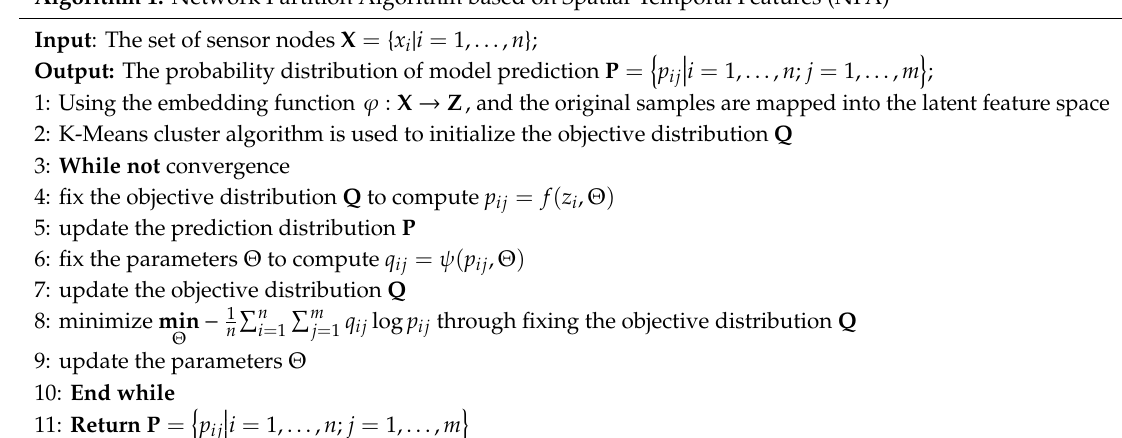
Algorithm 1. Network Partition Algorithm based on Spatial-Temporal Features